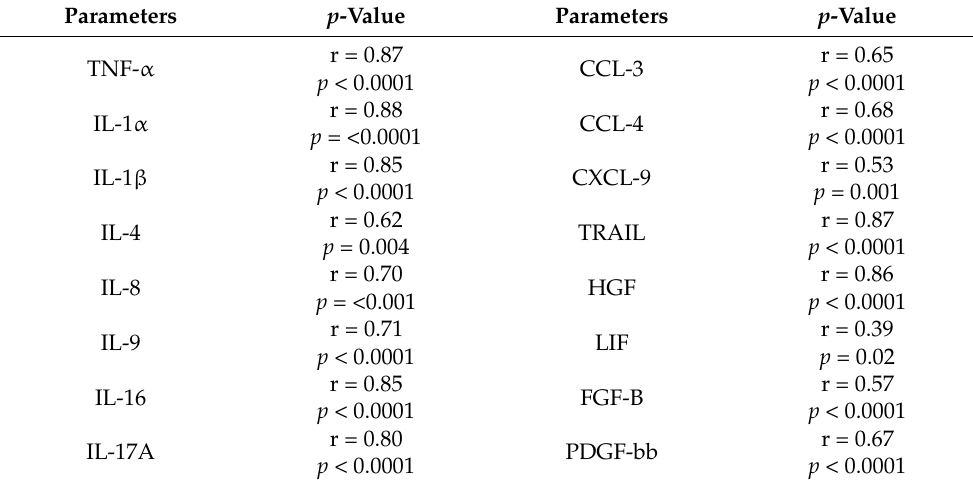
Table 2. Correlations between total urinary EVs and immune mediators.